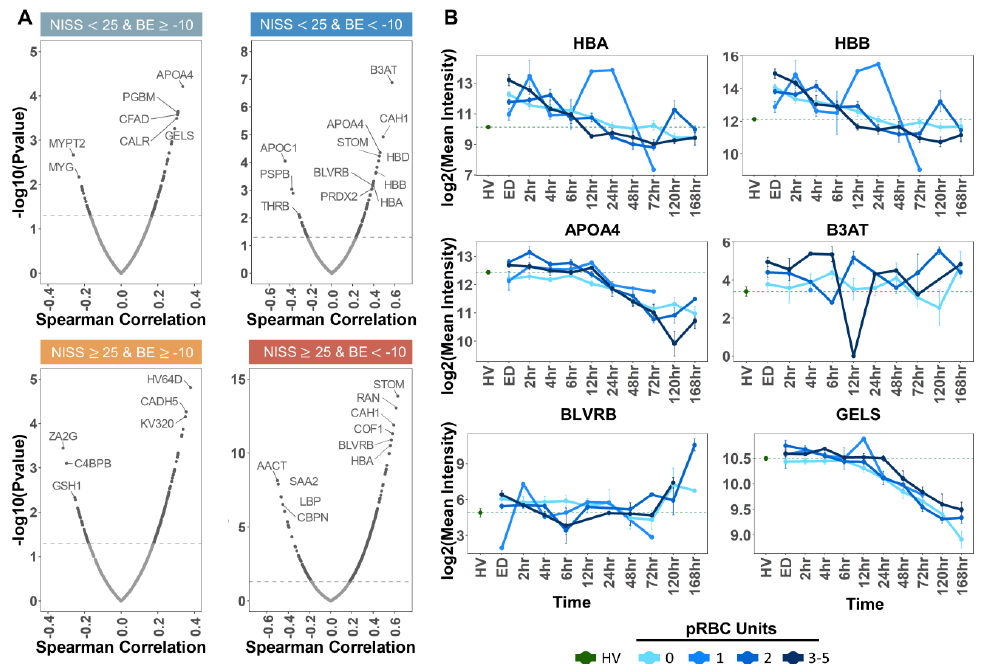
Figure 6. Protein correlates to RBC transfusion. In ( A ), Spearman correlations of total pRBC units with all detected proteins. Correlations were performed per severity group as indicated by BE and NISS cut-off values labeled above each plot. Patient samples at the ED time point were used for the correlations. The Spearman correlation values were plotted on the x-axis, and − log10 transformed p values were plotted on the y-axis. The dashed horizontal line indicates the significance threshold, − log10(0.05). In panel ( B ), temporal trends of top significant protein correlates identified in ( A ). The dashed green line indicates the log2 transformed mean healthy volunteer (HV) intensity. Patients were grouped by number of pRBC units received (0, 1, 2, or 3 – 5). The log2 transformed mean patient intensity was plotted at each time point from ED to 168 h per group. Bars represent the standard error at each time point.